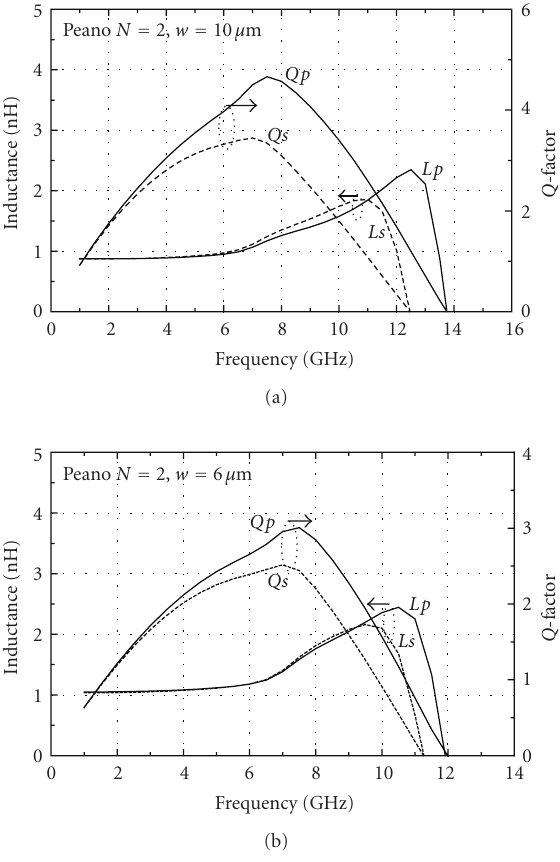
Figure 13: Q -factor and inductance versus frequency for Peano transformer with (a) w p = w s = 10 μ m, (b) w p = w s = 6 μ m.